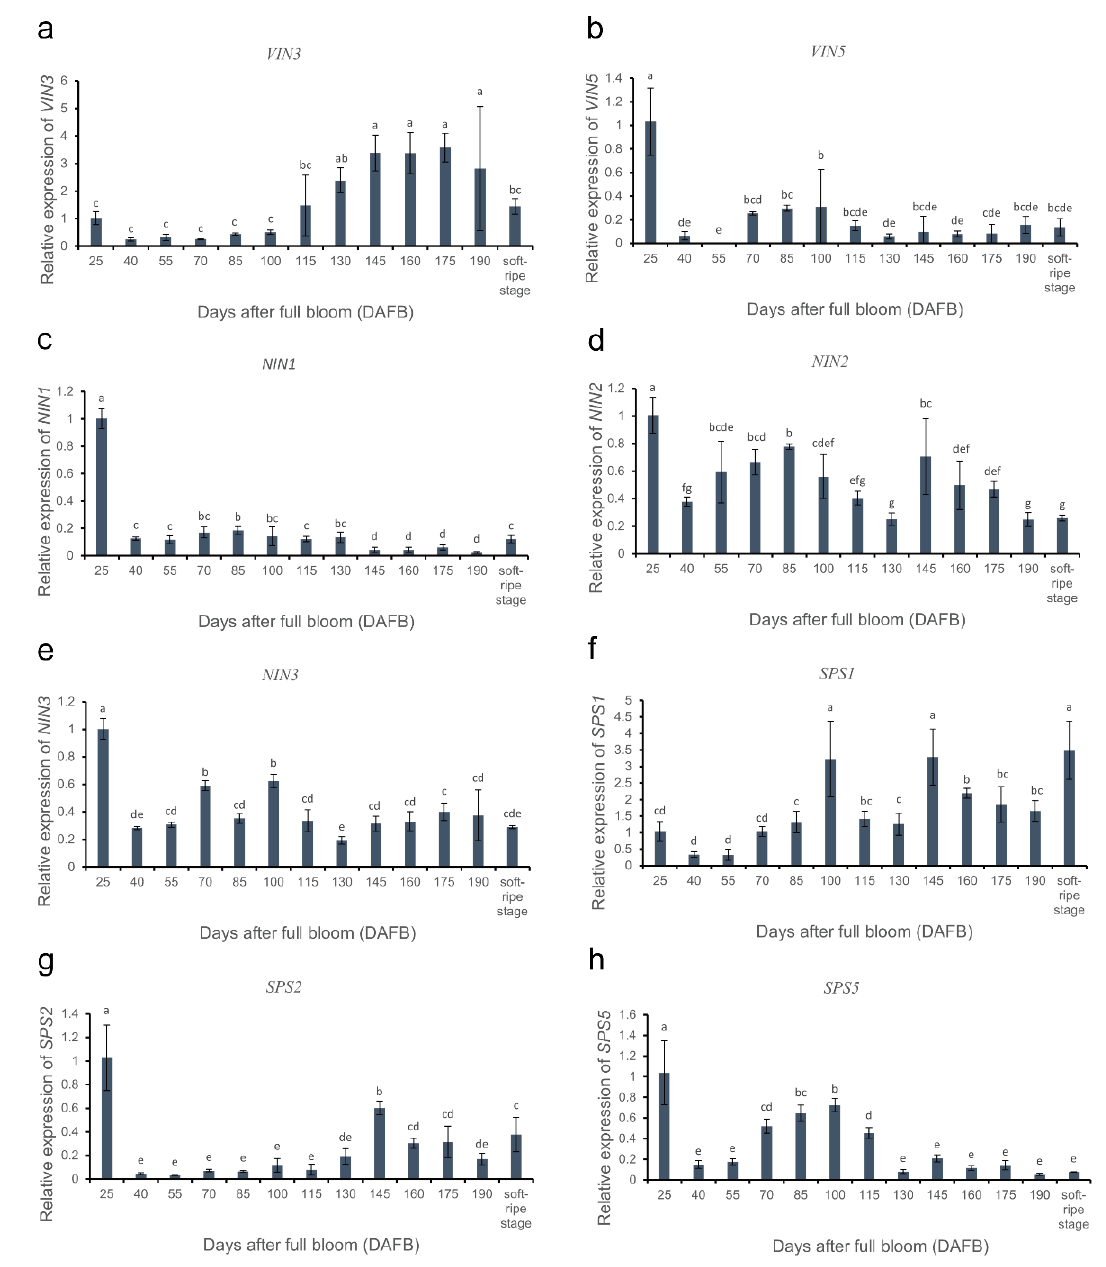
Figure 5. Expression patterns of sucrose metabolism-related genes over A. eriantha ‘Ganlv 1’ fruit development, including VIN3 ( a ); VIN5 ( b ); NIN1 ( c ); NIN2 ( d ); NIN3 ( e ); SPS1 ( f ); SPS2 ( g ) and SPS5 ( h